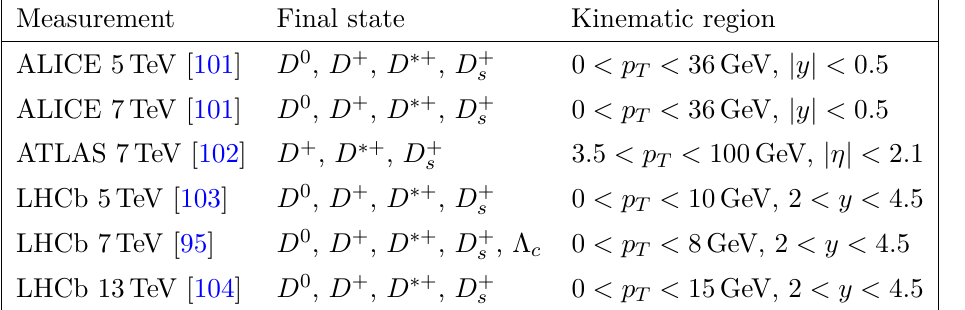
Table 4 . Summary of the most precise measurements of open charm production at the LHC. on the theoretical predictions, both ALICE and LHCb measurements are extrapolated to nearby regions of y , namely to 0 < | y | < 1 . 5 and | y | > 1 . 5 ,